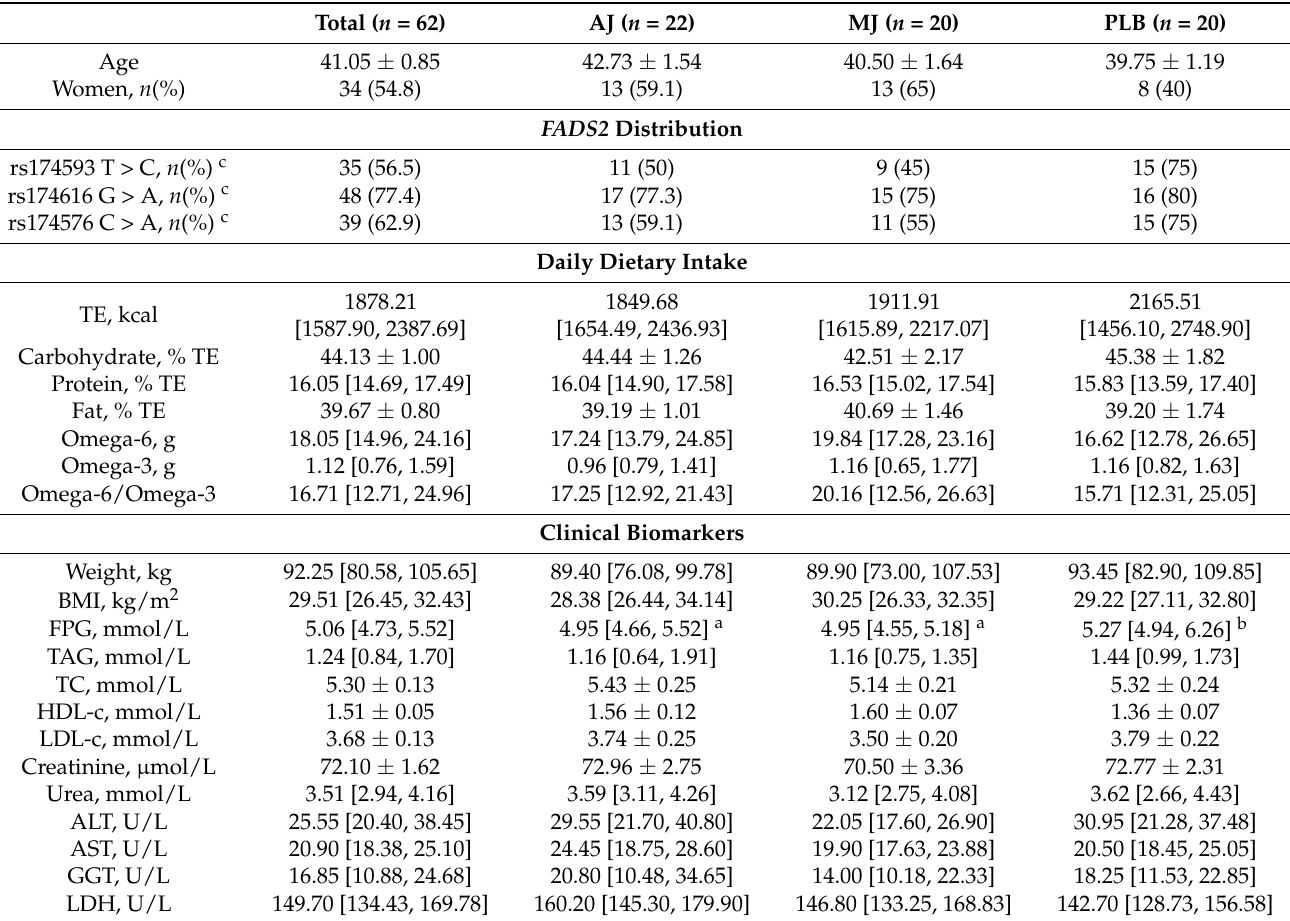
Table A1. Baseline characteristics of the study subjects who are overweight across the study intervention groups with varying polyphenol